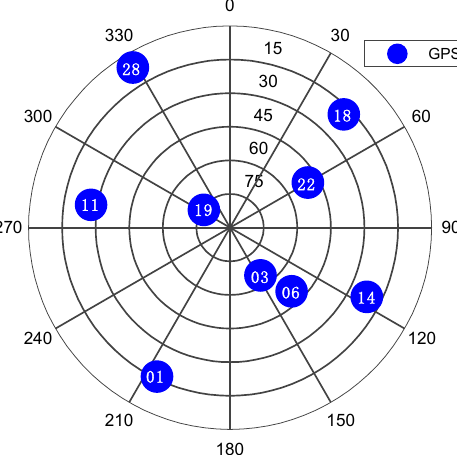
Figure 6. Skyplot of the GPS satellites in view during the experiment.